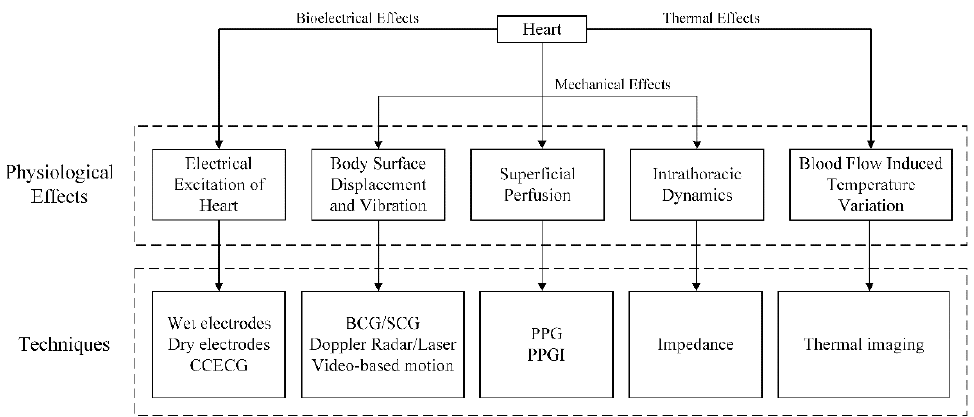
Figure 1. Overview of physiological effects and respective techniques for heart rate (HR) measurement.